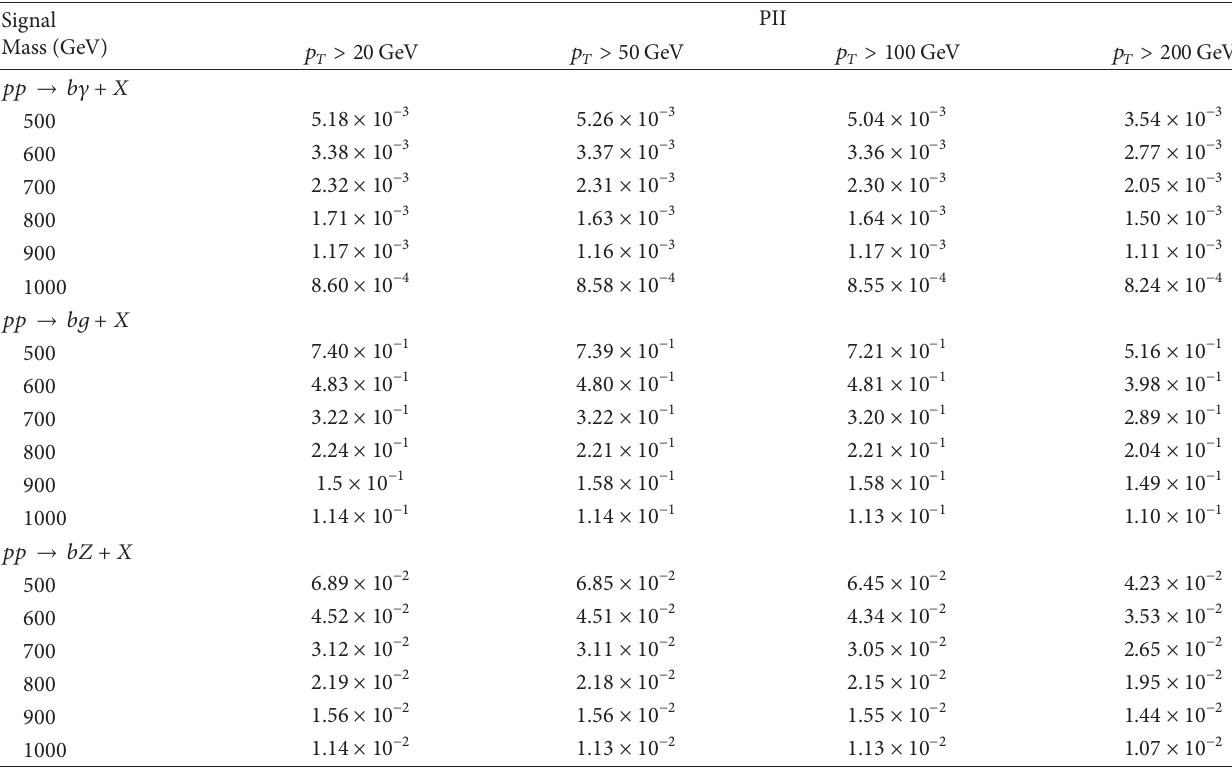
Table 12: The same as Table 11, but for parametrization PII.